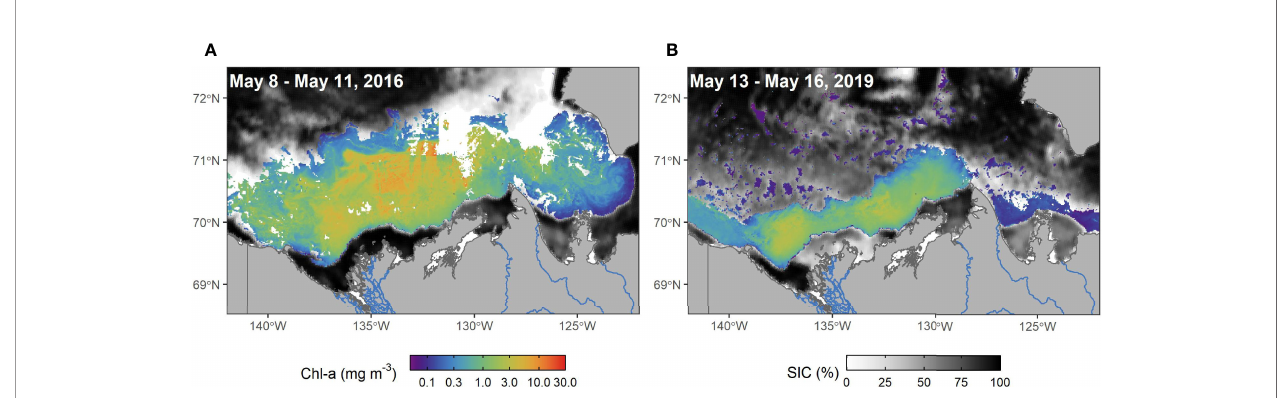
FIGURE 6 | Four-day composite images of SIC and Chl-a showing fl aw lead phytoplankton blooms during May. The geometric mean of Chl-a is shown from May 8- 11, 2016 (A) and May 13-16, 2019 (B)